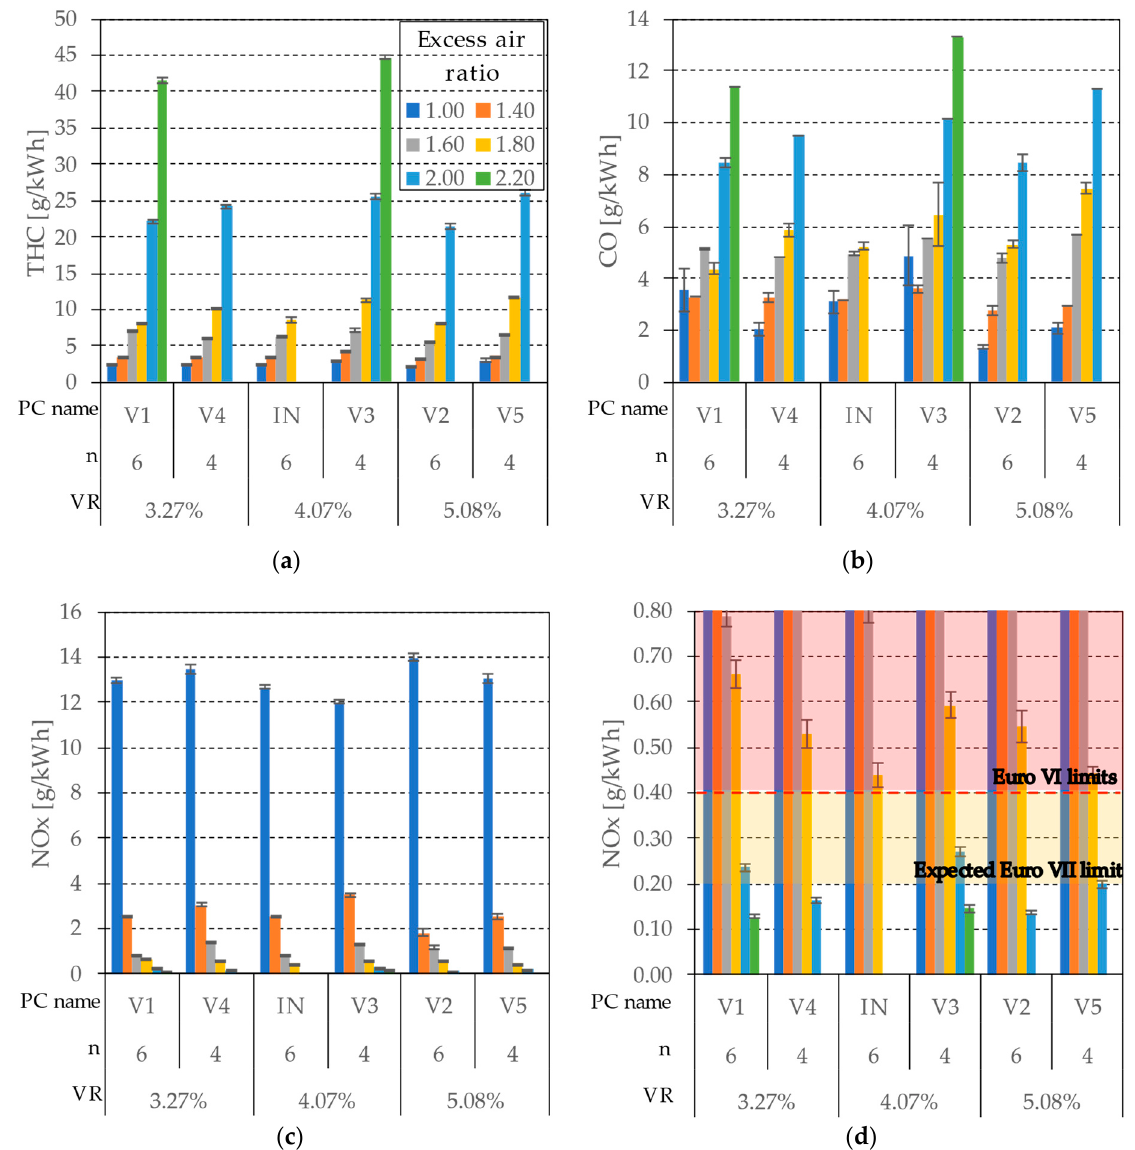
Figure 8. Exhaust gas emissions: ( a ) THC; ( b ) CO; ( c ) NOx; and ( d ) NOx enlarged with legislative NOx limit. For all PC types the orifice area to volume ratio OA = 0.003 mm − 1 .